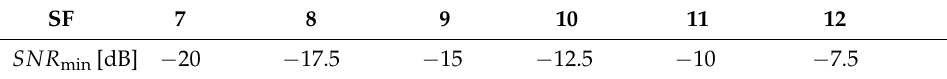
Table 3. SNR min values for different SF with BW = 125 kHz